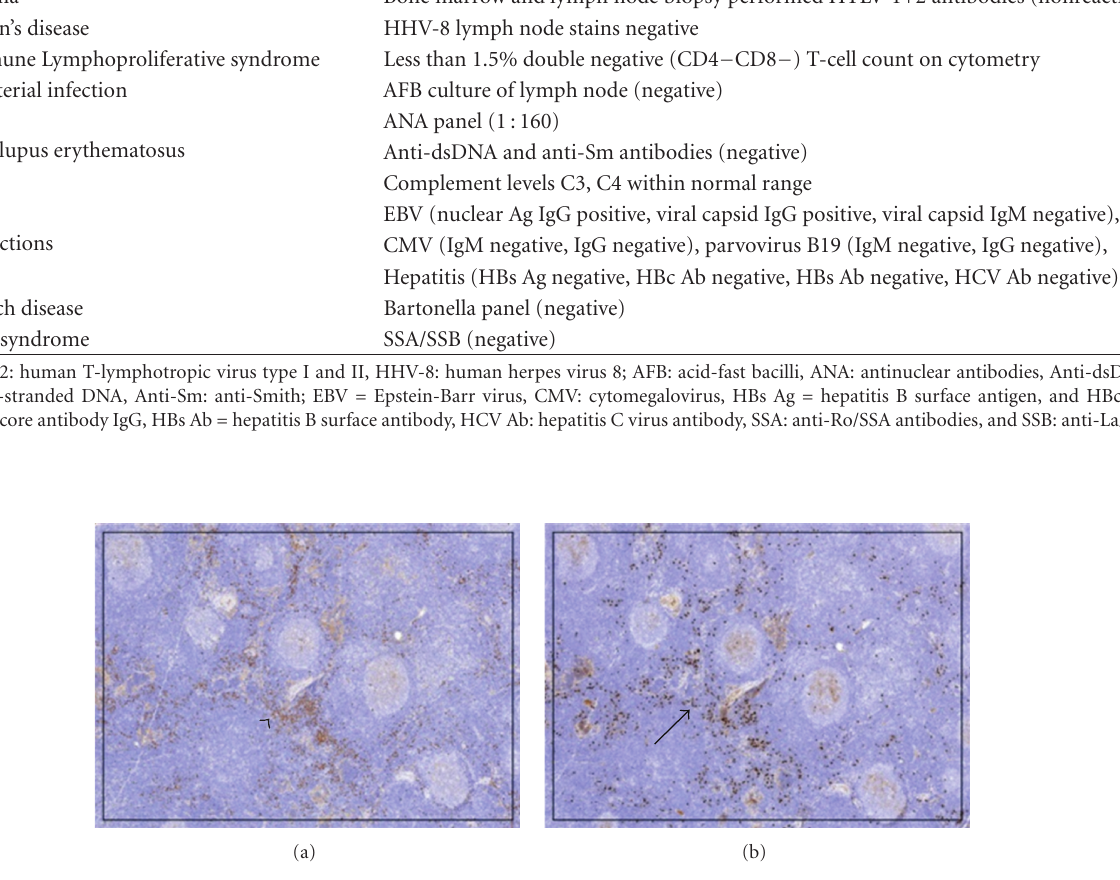
Figure 3: IgG (a) and IgG4 (b) stains, 4x magnification. These stains show an IgG4+/IgG+ cell ratio estimated at 30% (black arrow head: IgG staining, solid black arrow = IgG4 staining).